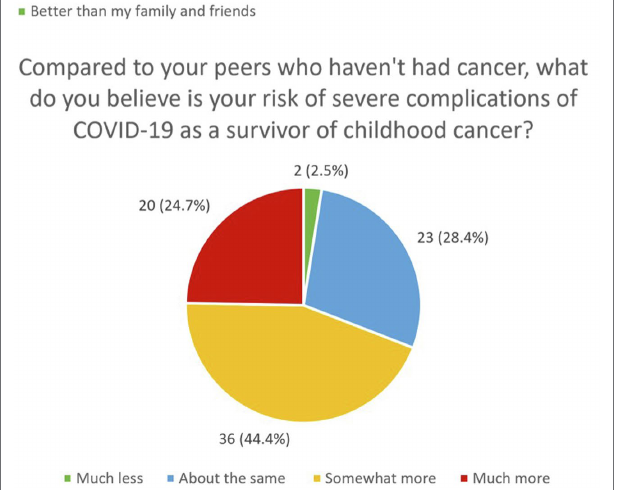
FIGURE 1 | The perceived impact of COVID-19 on the mental health status of AYA survivors.